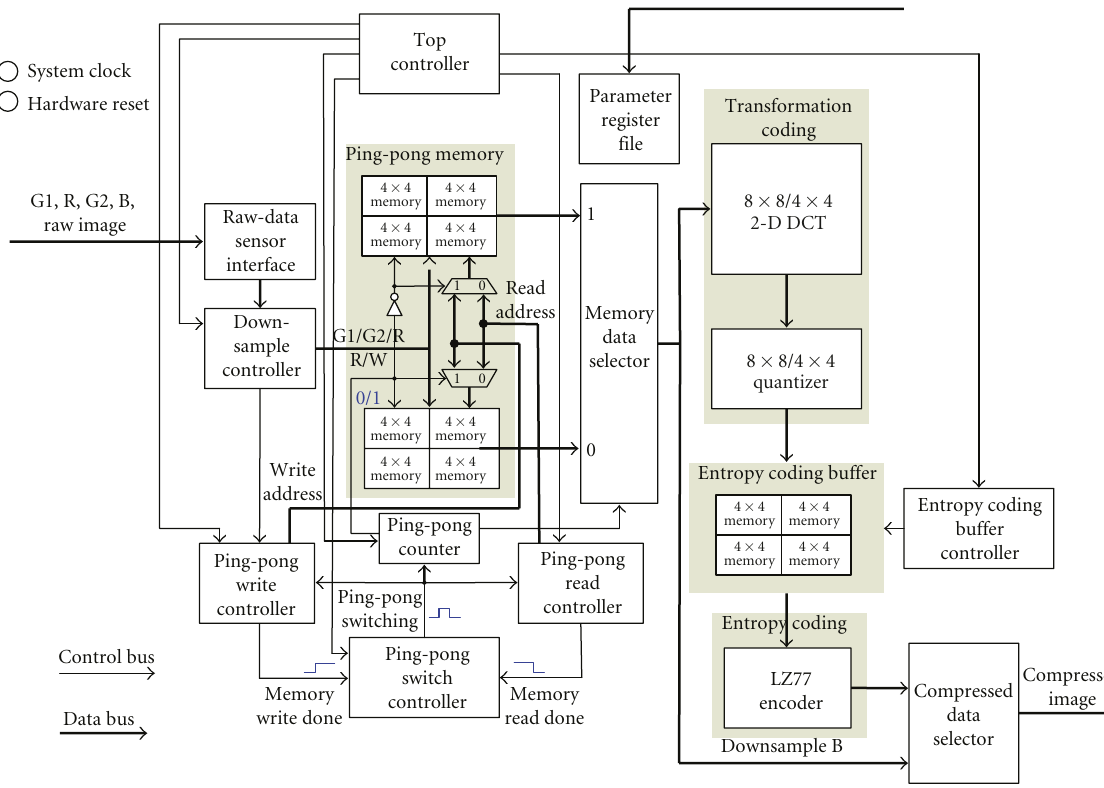
Figure 10: The GICam-II image